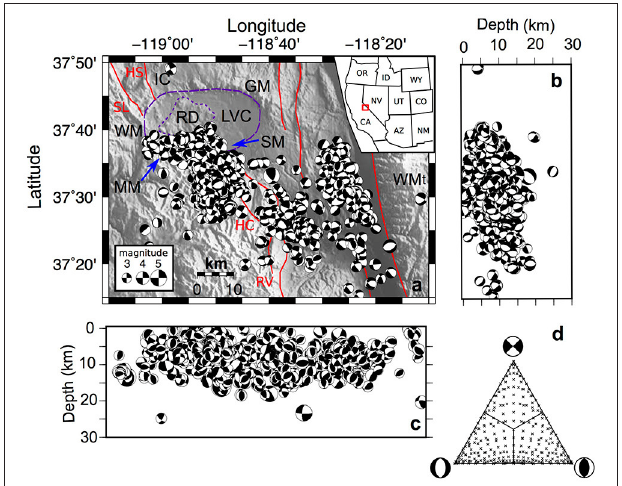
FIGURE 9 | Long Valley. Focal mechanisms dataset plotted on a shaded map (A) ;, on a N-S (B) , and an E-W (C) cross sections. (D) The distribution of focal mechanisms on a triangular Frohlich diagram ( Frohlich, 1992). The dataset consists of 38,000 events with 0 < M < 6.4 occurred between 1978 and 2015. For sake of clarity only the events with m > = 3 are plotted. LVC, Long Valley Caldera (purple dashed line); RD, Resurgent Dome (purple dotted line); IC, Inyo Craters; WM, West Moat; MM, Mammoth Mts.; SM, South Moat; GM, Glass Mts.; WMt, White Mts. Red lines represent the main fault systems of the LVc area: SL, Silver Lake; HS, Hartley Springs Fault; HC, Hilton Creek; RV, Round Valley. See text for data sources.